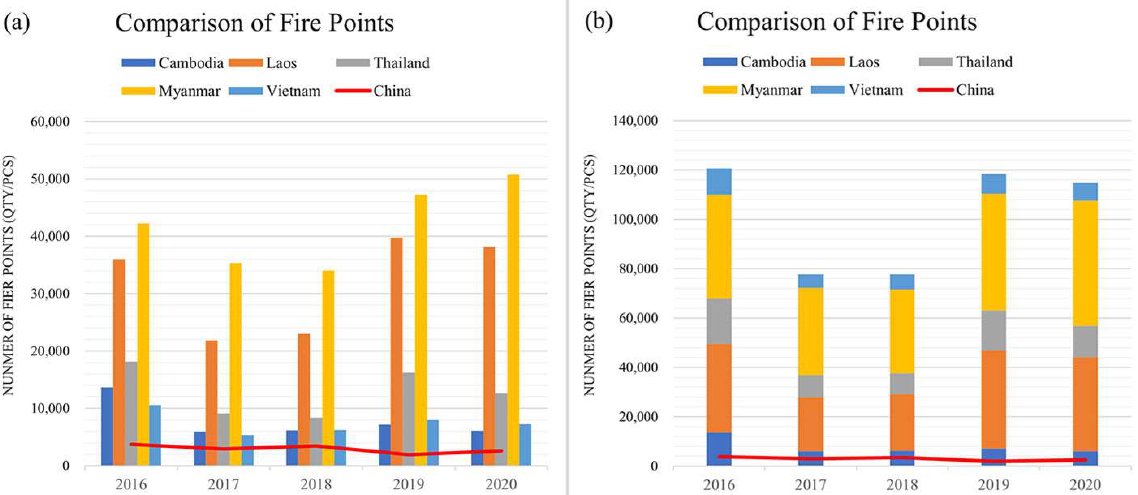
Figure 3. Comparison of the number of fire spots in the five countries of the Indochinese Peninsula and China’s Yunnan, Guangxi and Guangdong provinces. ( a ) comparison of fire points separately, ( b ) comparison of fire points in